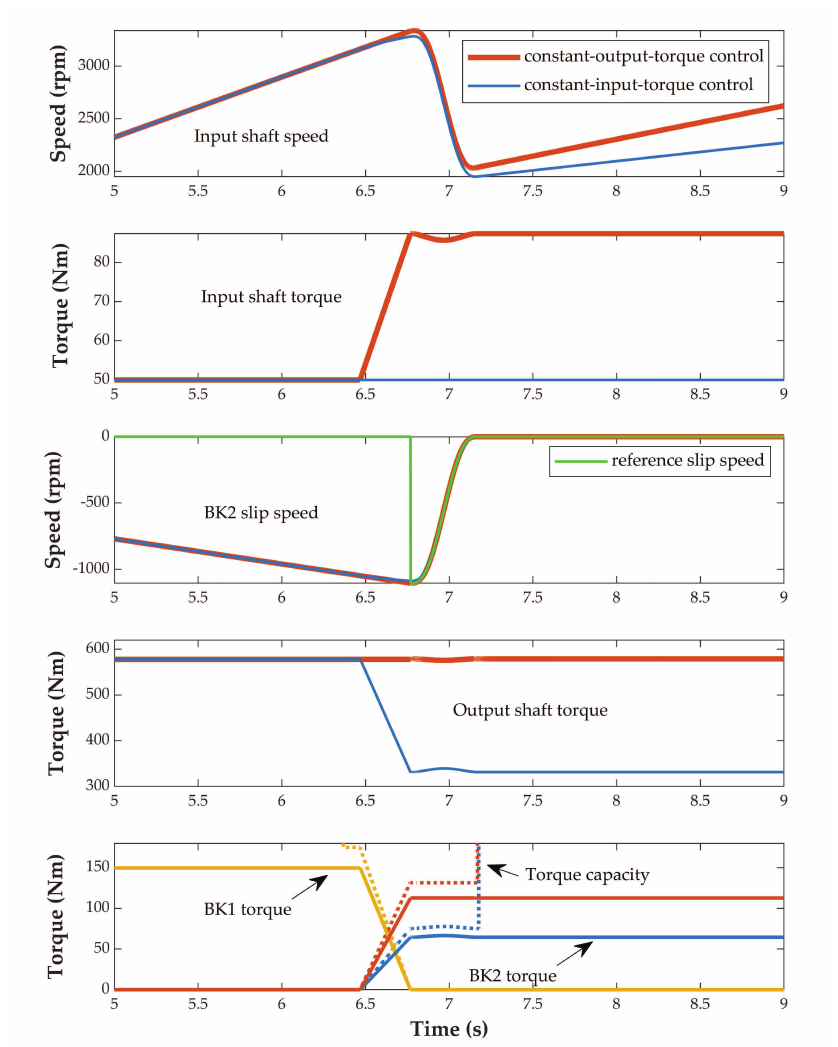
Figure 10. Comparison with constant-input-shaft torque